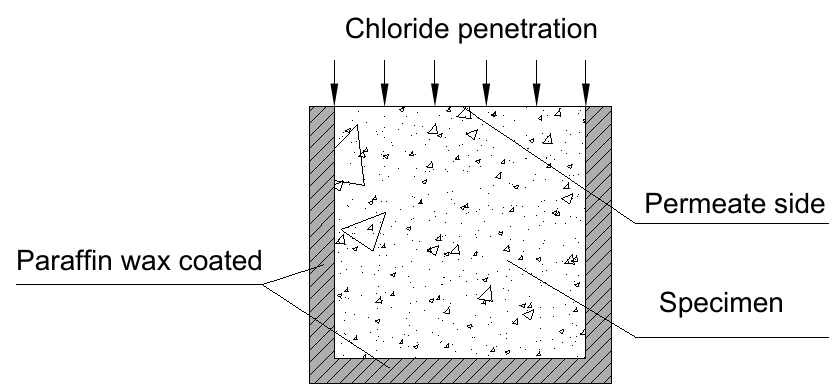
Figure 8. Specimen coated with paraffin wax.